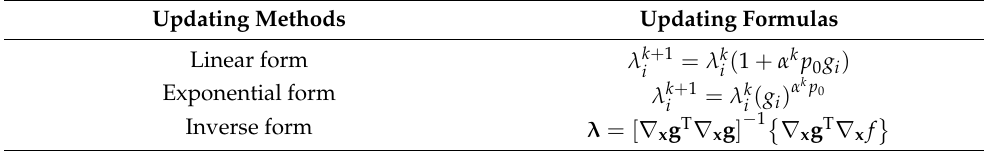
Table 1. Lagrange multiplier update